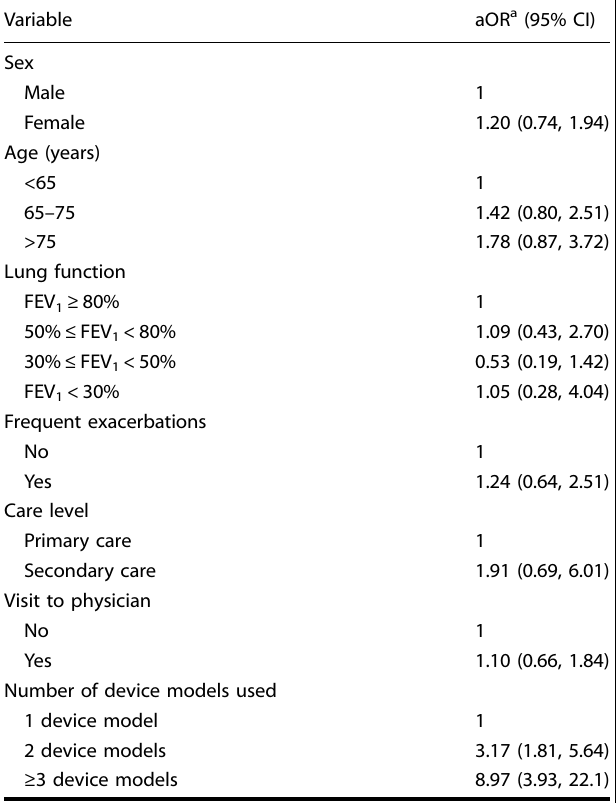
Table 3. aORs with 95% CIs for variables associated with ≥ 1 critical error with at least one of a patient ’ s inhaler device models in a multivariable logistic regression